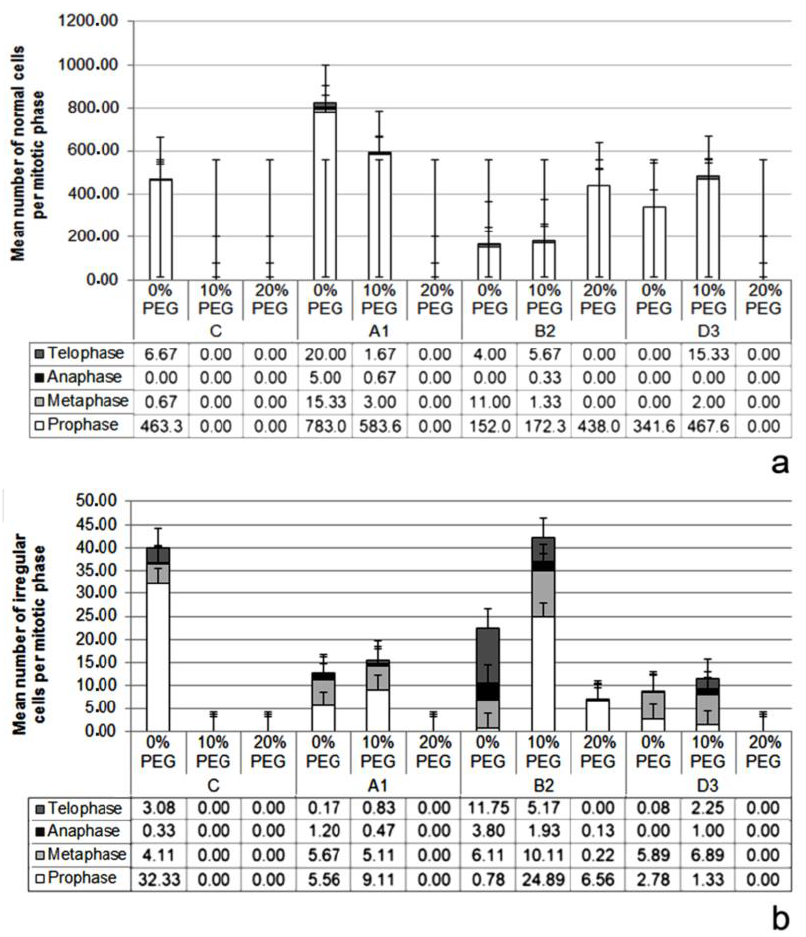
Figure 3. Mean (± S.E.) number of normal ( a ) and irregular ( b ) dividing cells per mitotic phase. For the mean number of normal metaphase cells, the effects of stand (S), treatment (T), and S × T interaction were statistically significant ( p -value < 0.05) (Table S1). For this mitotic phase, the mean number of normal cells was higher for 0%PEG than for 10%PEG treatment. The mean normal cell values of seeds collected from the once-burned stand (A1) were distinct from the others (C, B2, D3) ( p -value = 0.0282) (Table S1). The mean number of normal and irregular anaphase cells showed statistically significant differences ( p -value < 0.05) among S, T and/or S × T interactions (Table S1). Regarding the telophase cells, only the mean values of the irregular ones showed statistically significant differences ( p -value < 0.05) among S, T, or S × T (Table S1). The S factor significantly influenced the mean number of irregular anaphase and telophase cells, high in B2 (Table S1). The mean number of irregular metaphase, anaphase, and telophase cells differed significantly among PEG treatments (Table S1). In the 10% PEG treatments, a higher number of irregular telophase cells were identified in stands that burned twice (B2) and three times (D3) (Table S1). Concerning the S × T interactions, the highest mean values of irregular telophase cells were determined for B2 × 0% PEG, B2 × 10% PEG, C × 0% PEG, and D3 × 10% (Figure 3). Independently of the stand or PEG treatment, the irregular dividing cells showed three to five different types of anomalies per mitotic phase (Figure 4; Table S2). The anomalies presented in Figure 4 are representative of those observed in all stands and/or PEG